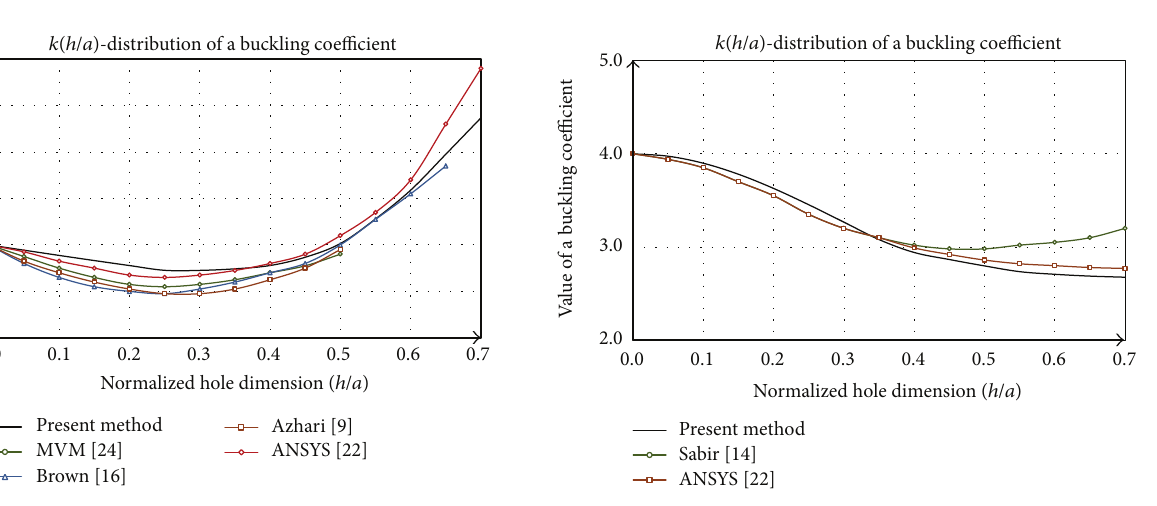
Figure 4: Comparative analysis of buckling coefficient of square plate with a rectangular hole.